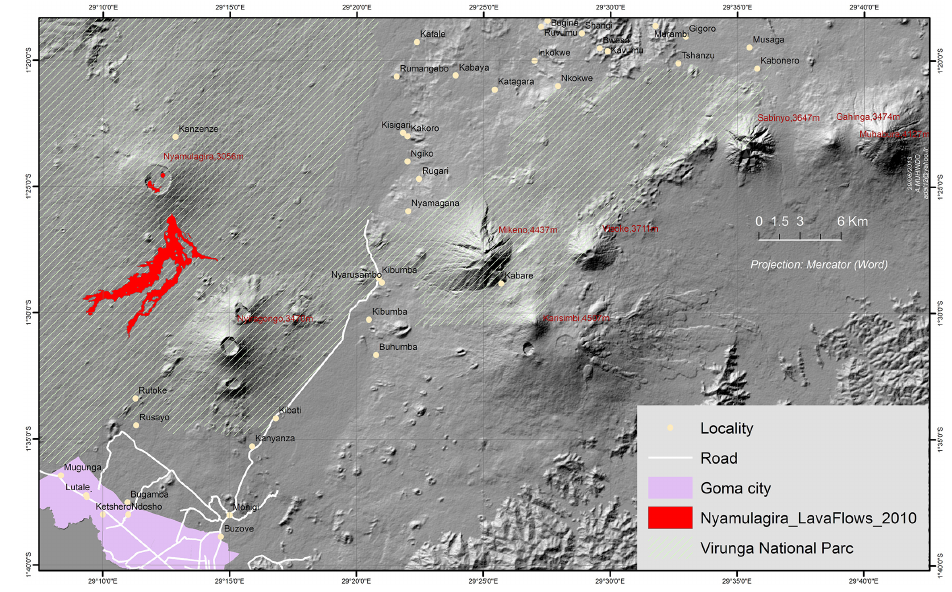
Figure 1. Location of the Virunga region with the Nyamulagira volcano and 2010 lava flows indicated in